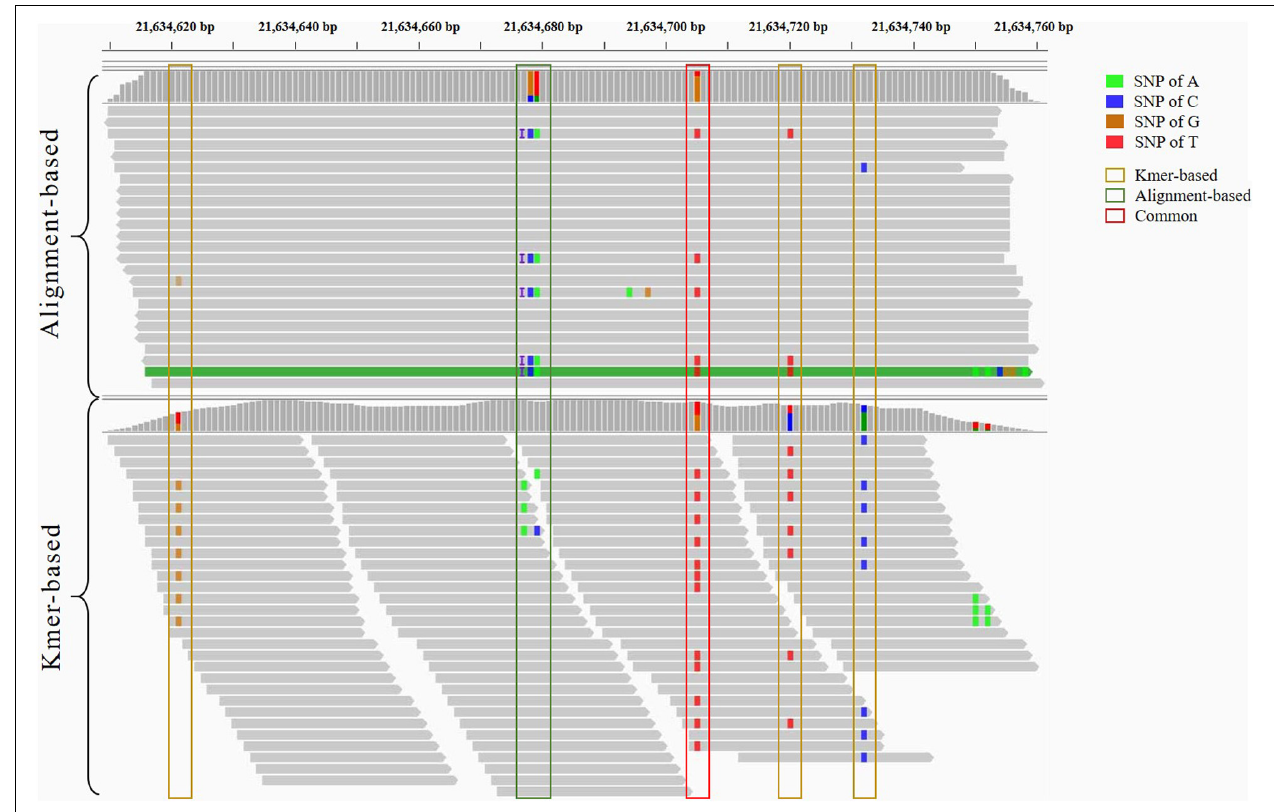
FIGURE 4 | The detailed comparison of genetic variants detected by the alignment-based and k -mer-based strategies. Both strategies detect the variant in the red border. Furthermore, the variants in yellow borders are detected only by k -mer-based strategy. The variant and insertion in the green border are detected only by alignment-based